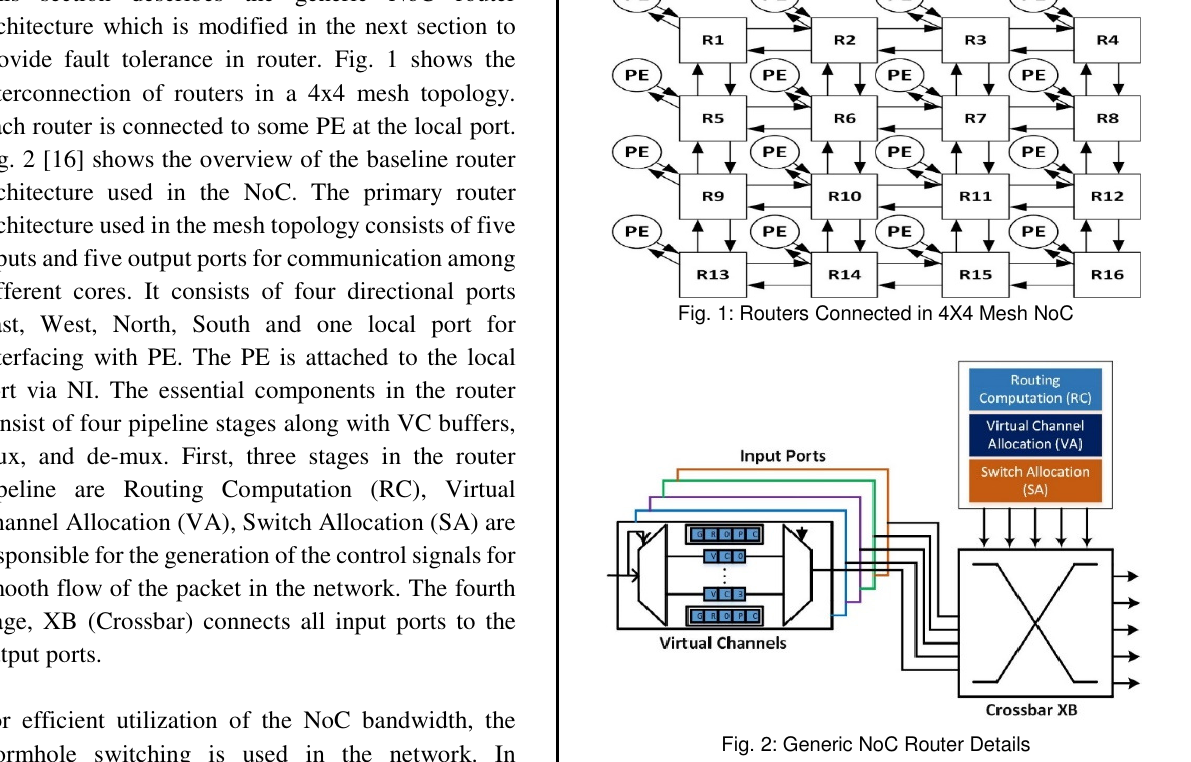
Fig. 1: Routers Connected in 4X4 Mesh NoC